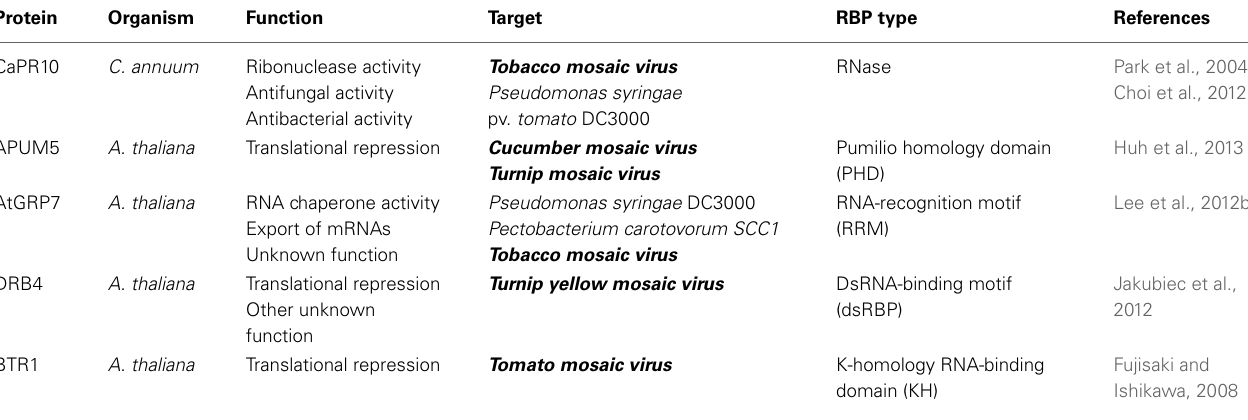
Table 1 | RNA-binding proteins involved in plant RNA virus